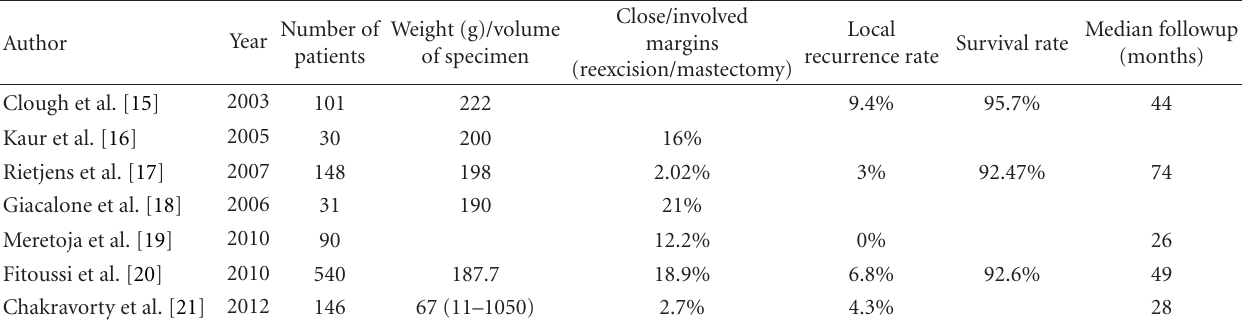
Table 1: Oncoplastic surgery and margin involvement, local recurrence rates, and survival